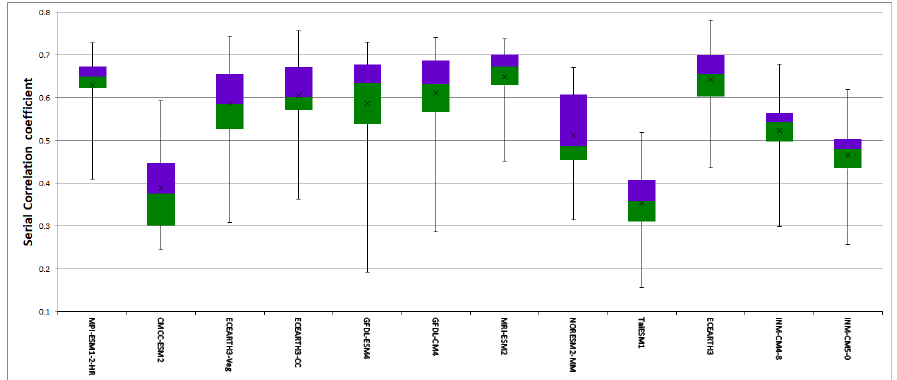
Figure 9. Box plots of the monthly precipitation correlation coefficients for each climate mode obtained across all climate stations in UASB.